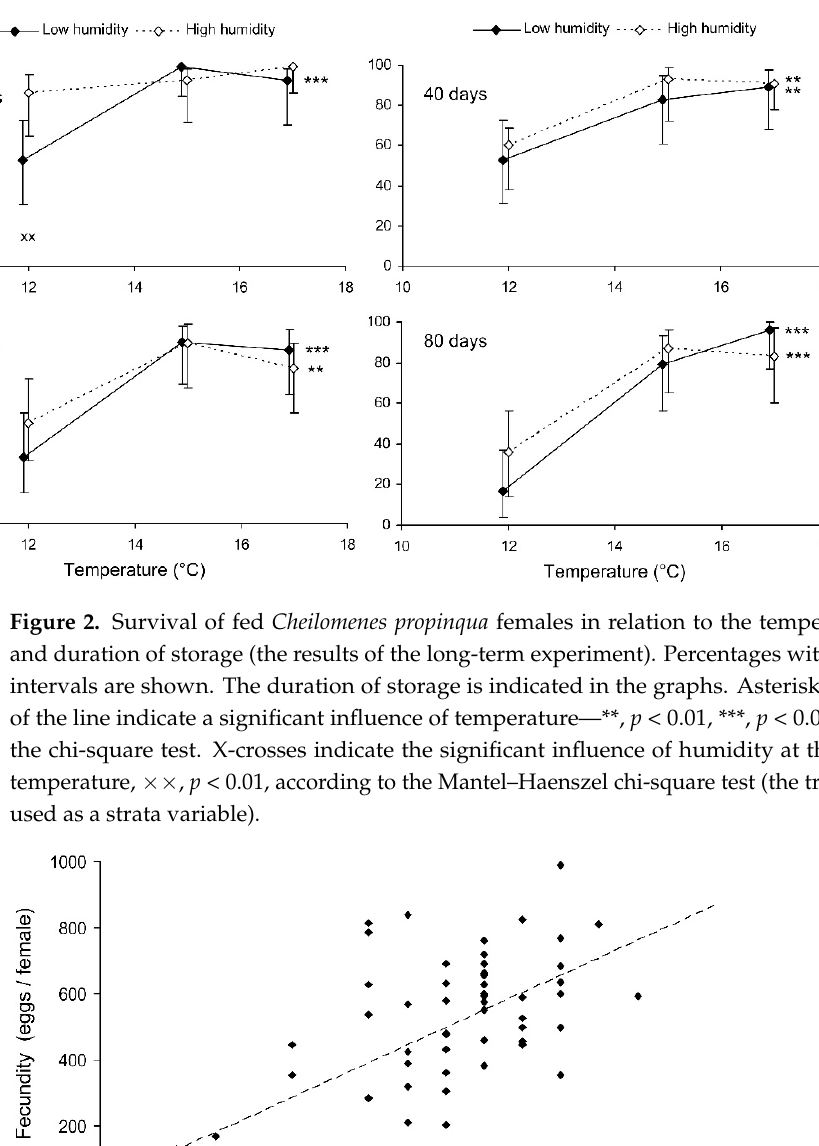
Figure 4. Fecundity of Cheilomenes propinqua females in relation to the temperature, humidity, trophic regime, and duration of storage (the results of the short-term experiment). The means and SD of the percentage of the expected fecundity calculated based on the female size are shown. The duration of storage is indicated in the graphs. Asterisks at the right end of the line indicate a signif- icant influence of temperature—*— p < 0.05, **— p < 0.01, ***— p < 0.001—according to a one-way ANOVA test. Plus symbols indicate the significant influence of the trophic regime at the correspond- ing temperature, +— p < 0.05, +++— p < 0.001, according to a two-way ANOVA test (humidity was the second factor).